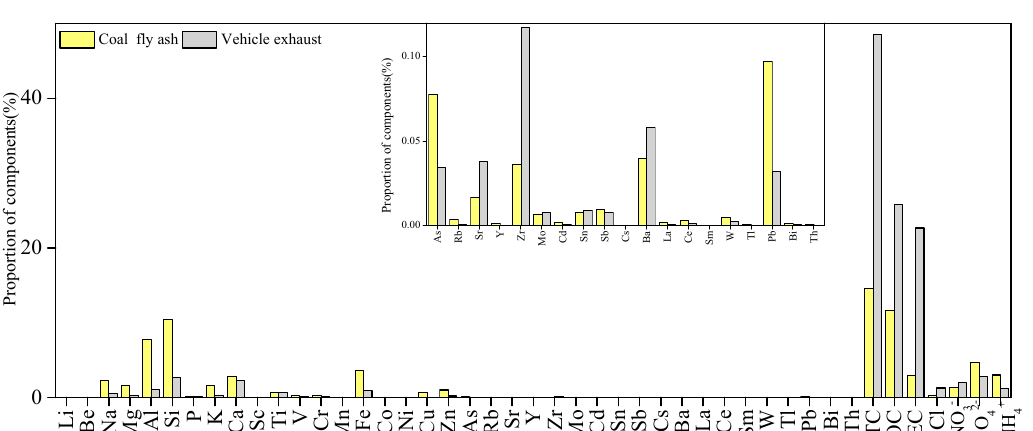
Atmosphere 2020 , 11 , x FOR PEER REVIEW Figure 10. Fugitive dust and soil dust source profile. Figure 10. Fugitive dust and soil dust source profile.